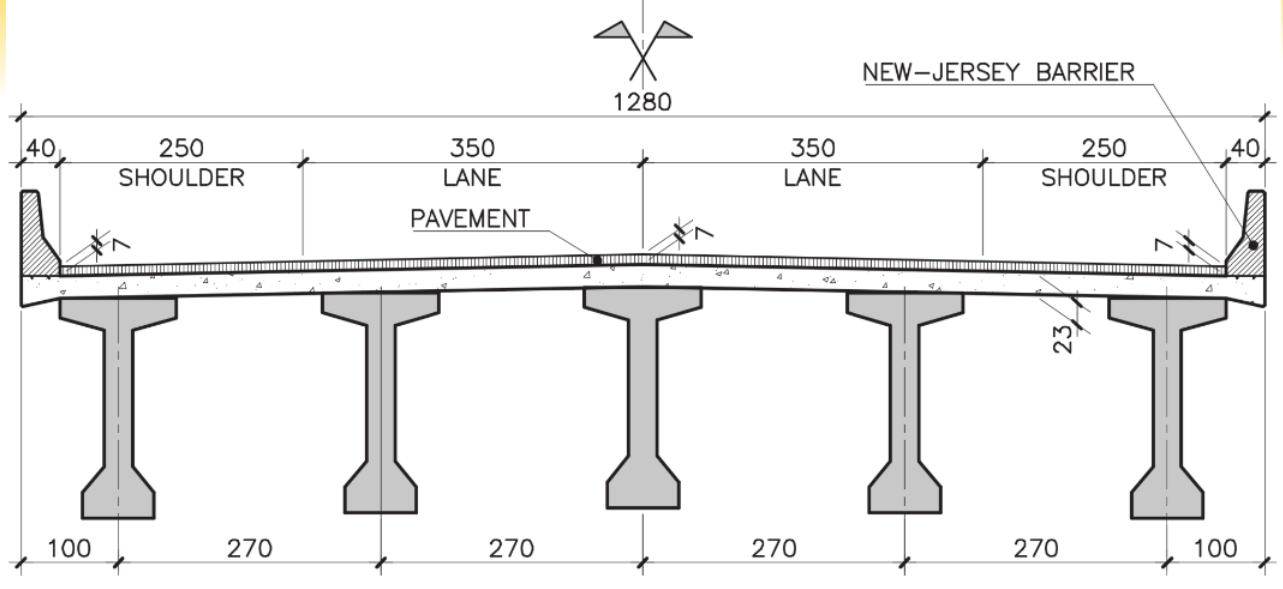
Typical cross section of multi-girder bridges